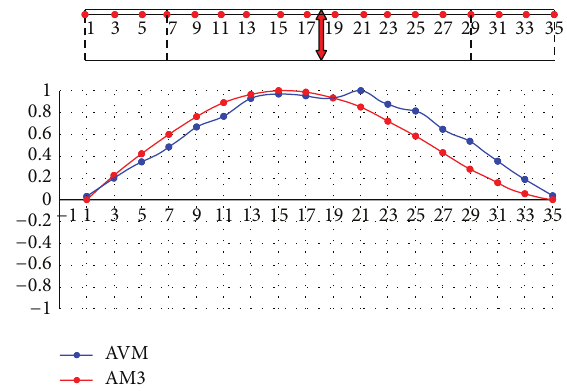
Figure 26: Experimentally and mathematically identified first transverse mode shapes.